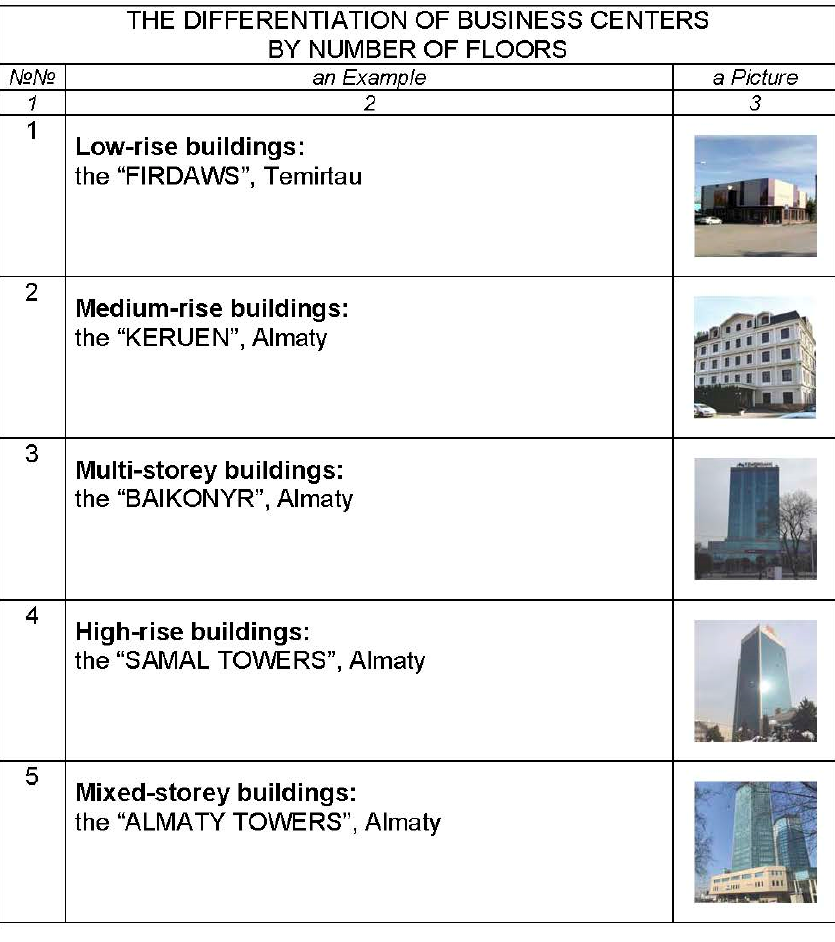
Figure 13. The differentiation of business centers by number of floors: ( 1 ) the FIRDAWS, Temirtau [121]; ( 2 ) the KERUEN, Almaty [122]; ( 3 ) the BAIKONYR, Almaty [123]; ( 4 ) the SAMAL TOWERS, Almaty [124]; and ( 5 ) the ALMATY TOWERS, Almaty [125].